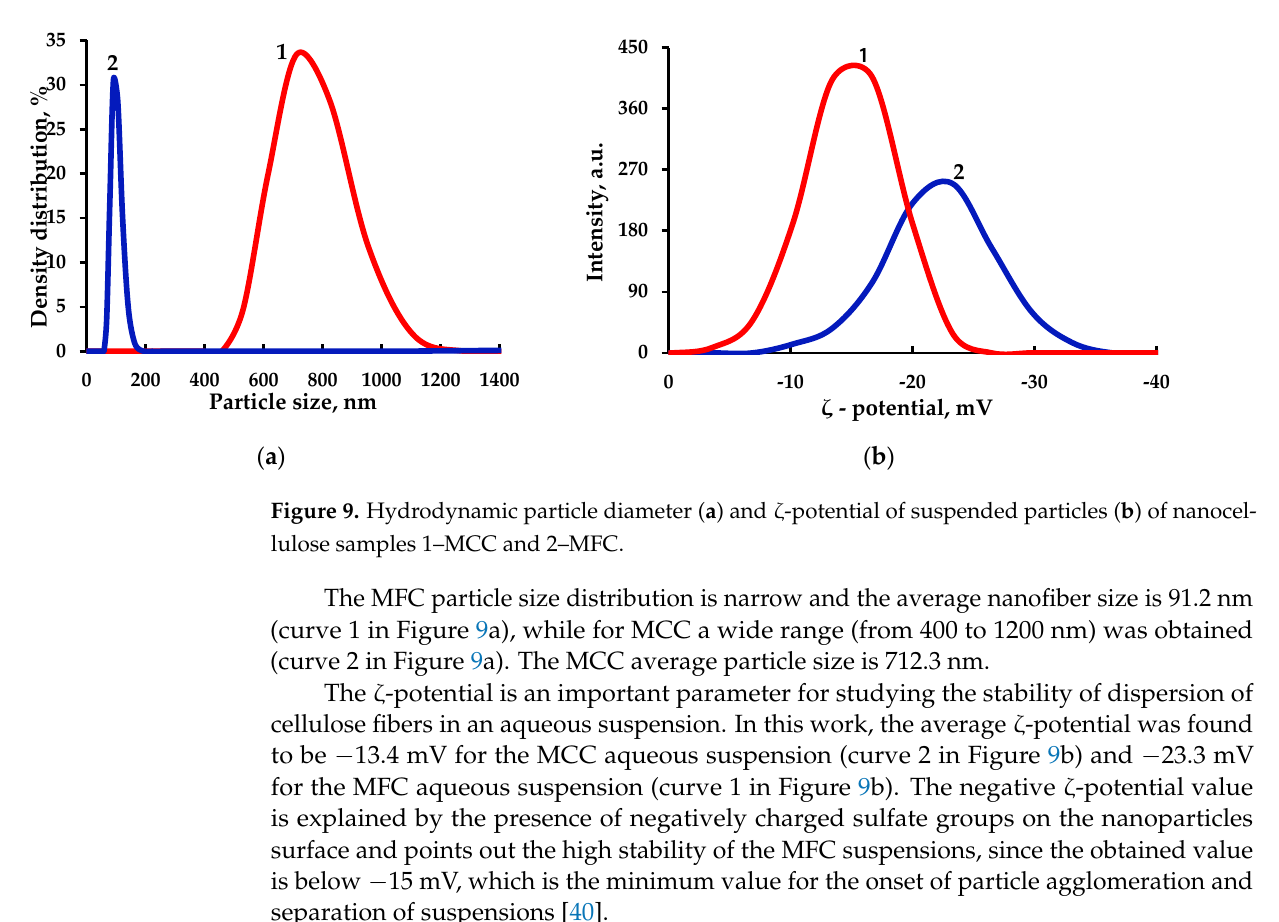
Figure 8. Micrographs of cellulose samples: ( A ) MCC; ( B ) MFC.